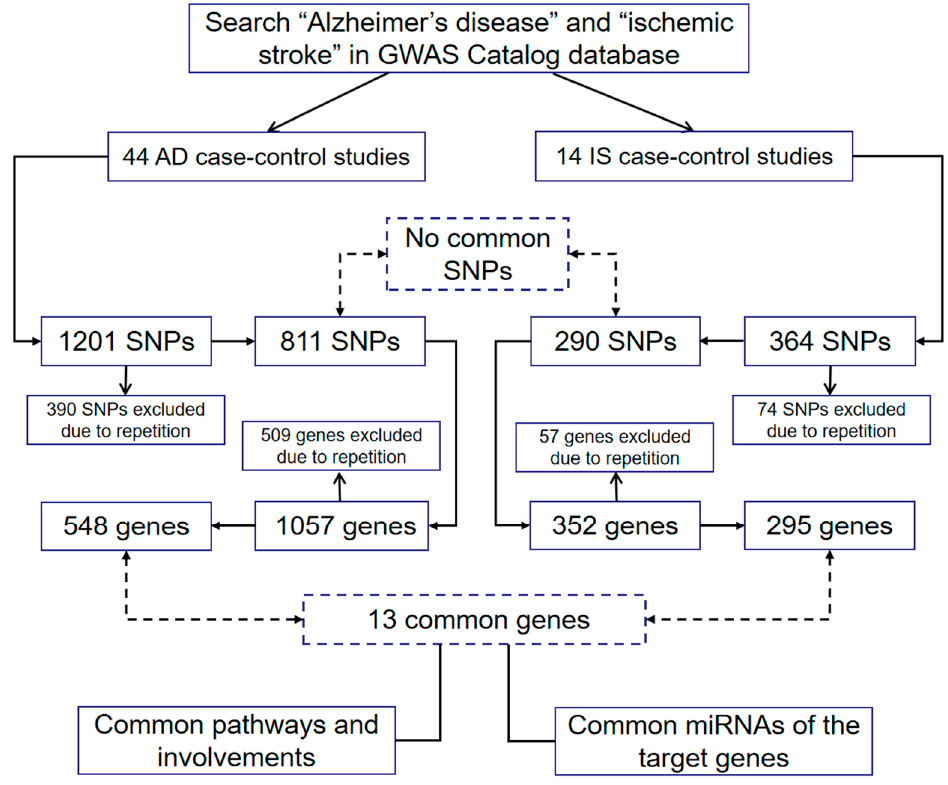
Figure 1. The molecular selection processes. Abbreviation: AD: Alzheimer’s disease; GWAS: genome-wide association study; IS: ischemic stroke; miRNAs: microRNAs; SNP: single nucleotide polymorphism.